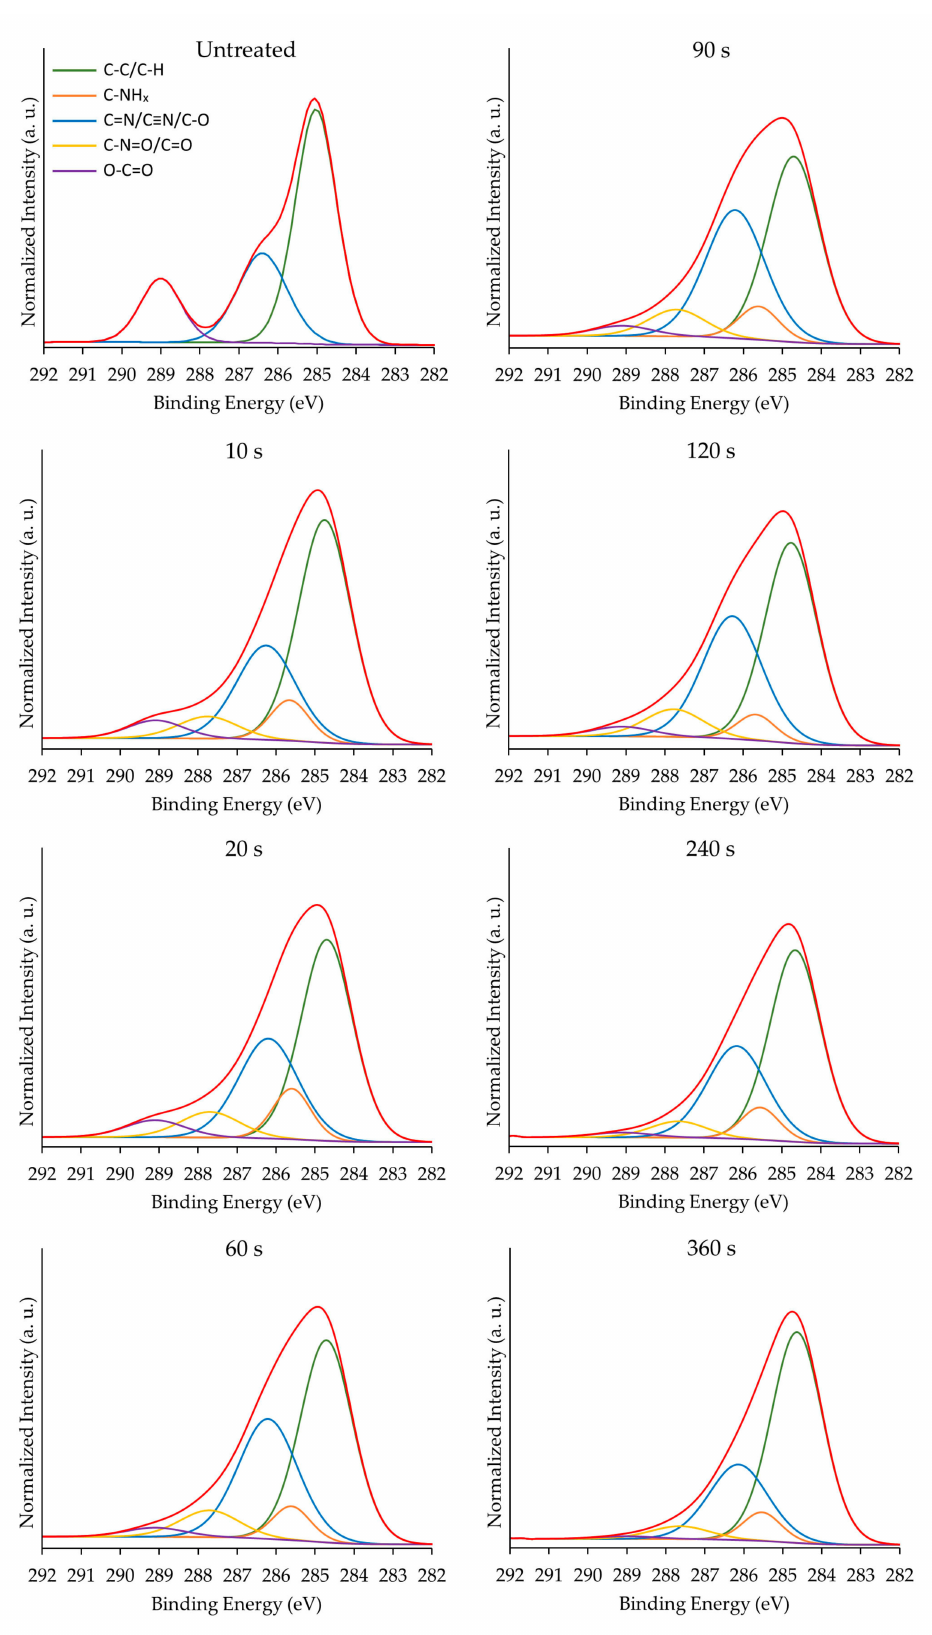
Figure 5. The deconvolution of XPS high resolution C1s peaks of untreated PCL NFs and PPF-NFs with a deposition duration varying between 10 and 360